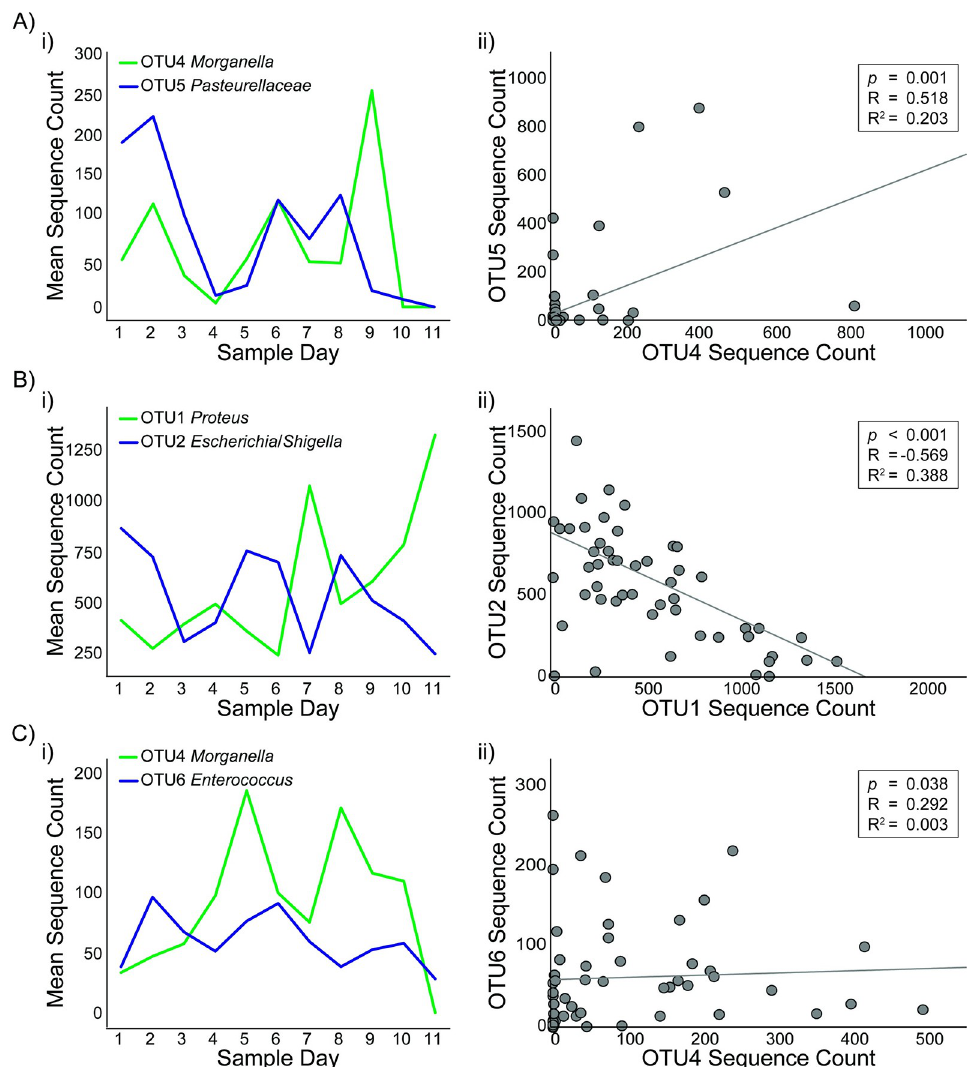
Fig 4. Examples of strong correlations in paired OTU sequence counts during baseline period. A) Strong negative correlation between OTU1 ( Proteus ) and OTU5 ( Pasteurellaceae ) for all animals i) mean relative abundances and ii) paired scatter plot. B) Strong positive correlation between OTU9 ( Aerococcus ) and OTU10 ( Jeotgalicoccus ) in all animals, i) mean relative abundances and ii) paired scatter plot. C) Strong positive correlation between OTU13 ( Romboutsia ) and OTU17 ( Turicibacter ) in all animals, i) mean relative abundances and ii) paired scatter plot.